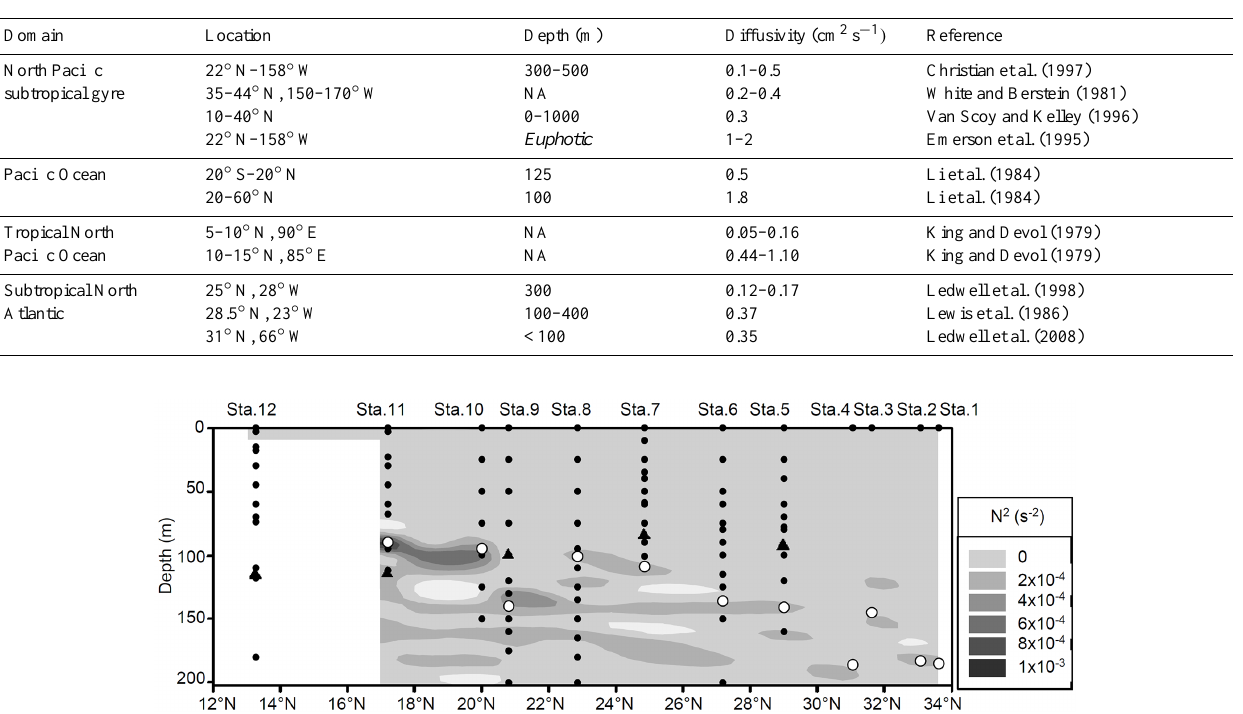
Table 1. Literature estimates of vertical turbulent diffusivity rates obtained using different methods in the oligotrophic condition. NA indicates information not mentioned.